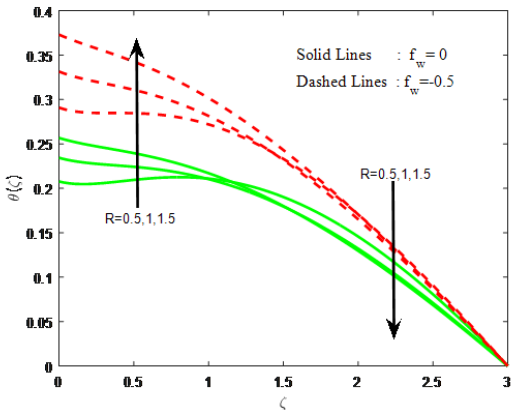
Fig. 9: The effect of Eckert number Ec on temperature field